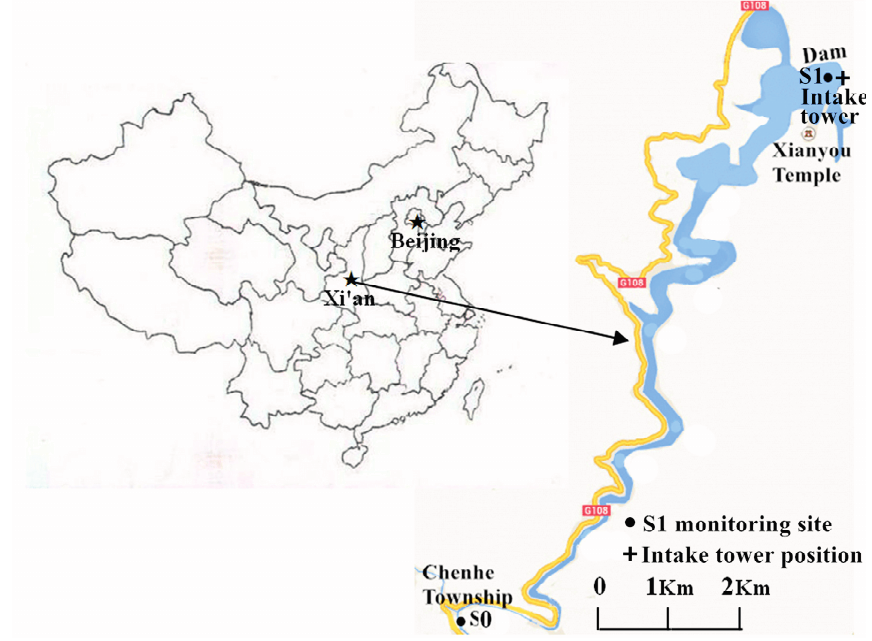
Figure 1. Location of the Heihe Reservoir and the sampling